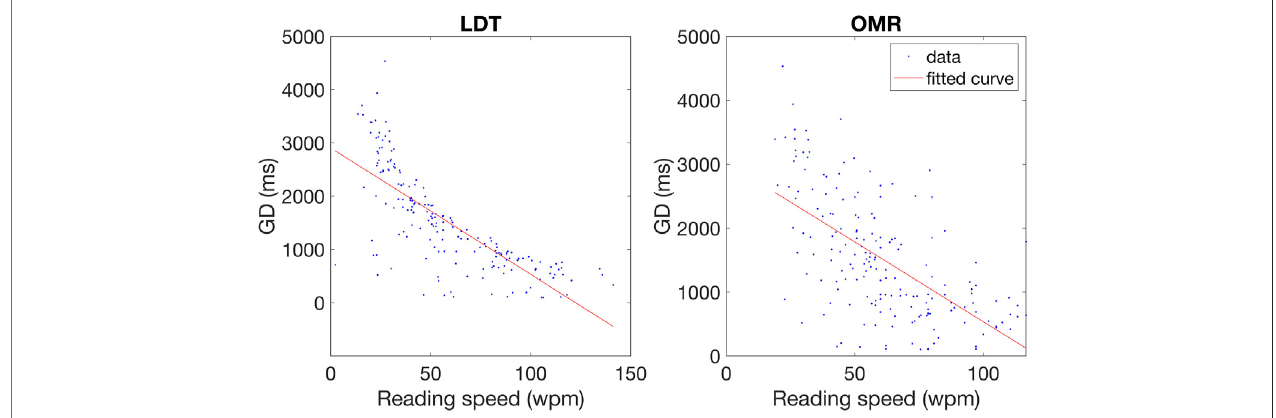
FIGURE 4 | Scatter plots showing the relation between gaze duration (GD in milliseconds) and reading speed (wpm) in the Lexical Decision Task (LDT – left panel, R 2 (cid:2) 0.58) and the One-Minute Reading test (OMR – right panel, R 2 (cid:2) 0.38) averaged across words and pseudowords. Lines are best fi tting linear regressions.